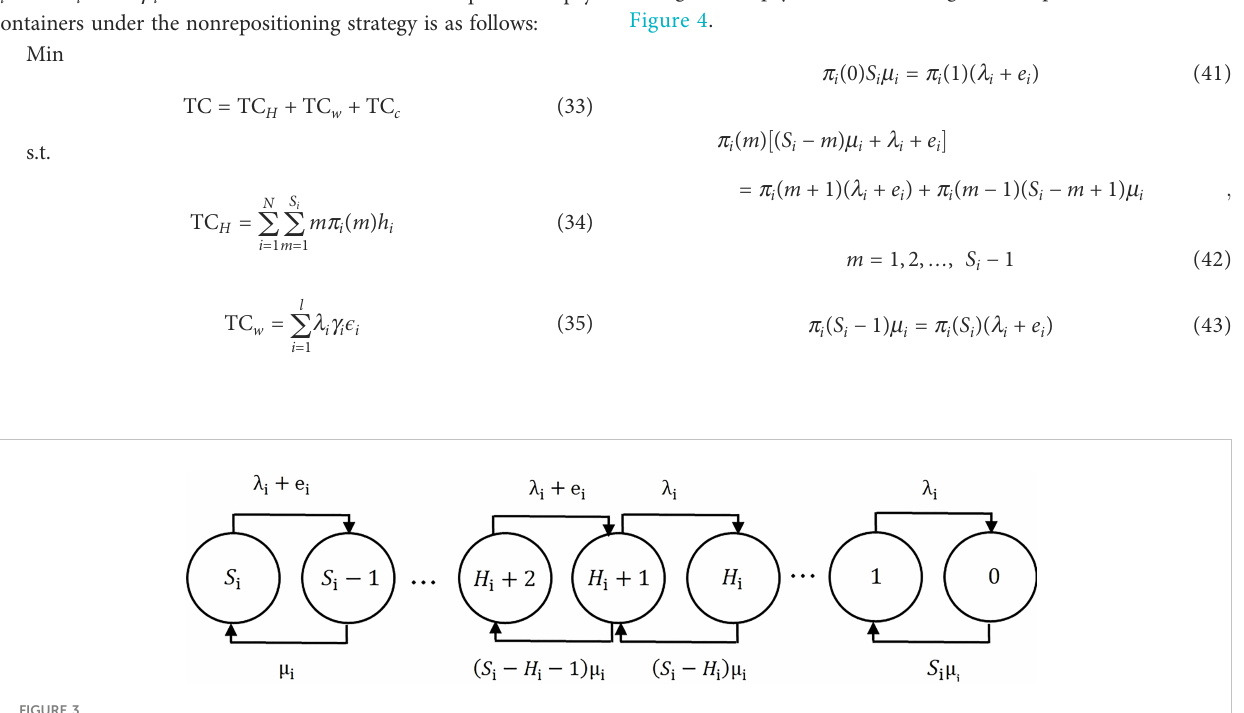
FIGURE 3 The change of port i empty-container storage under the nonrepositioning